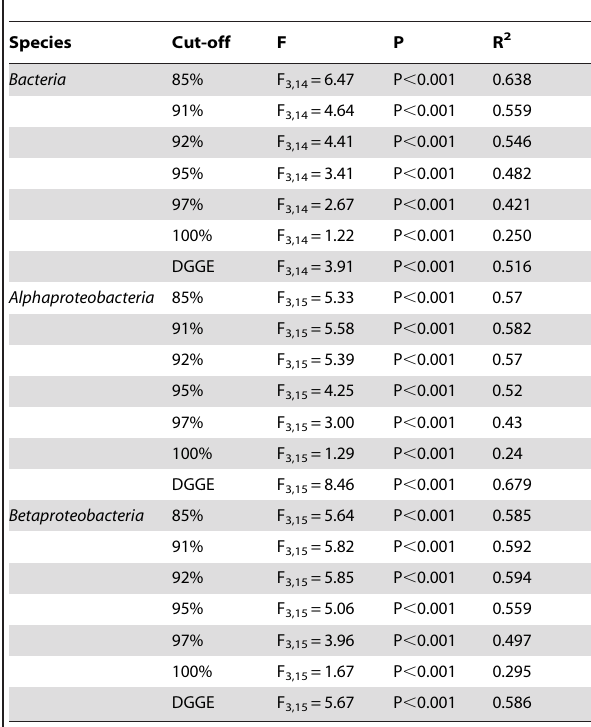
Table 1. Results of adonis analyses with the Bray-Curtis distance matrix of OTU composition as the response variable and microhabitat the independent